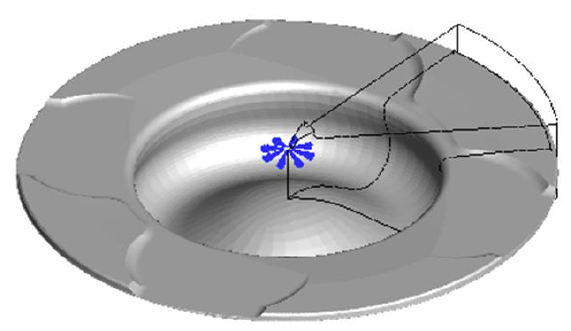
Figure 4. Selected cylinder sector from the entire combustion bowl geometry.